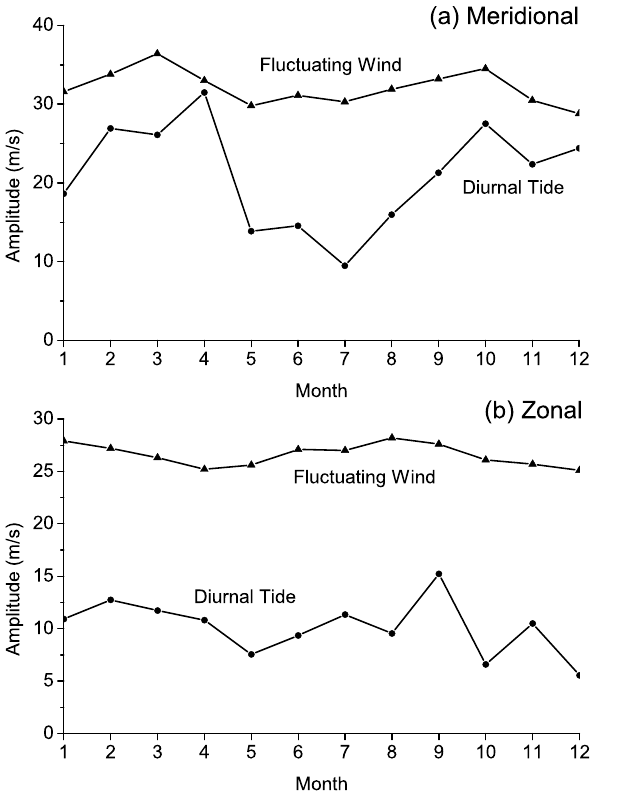
Fig. 4. As for Fig. 3 but for Cachoeira